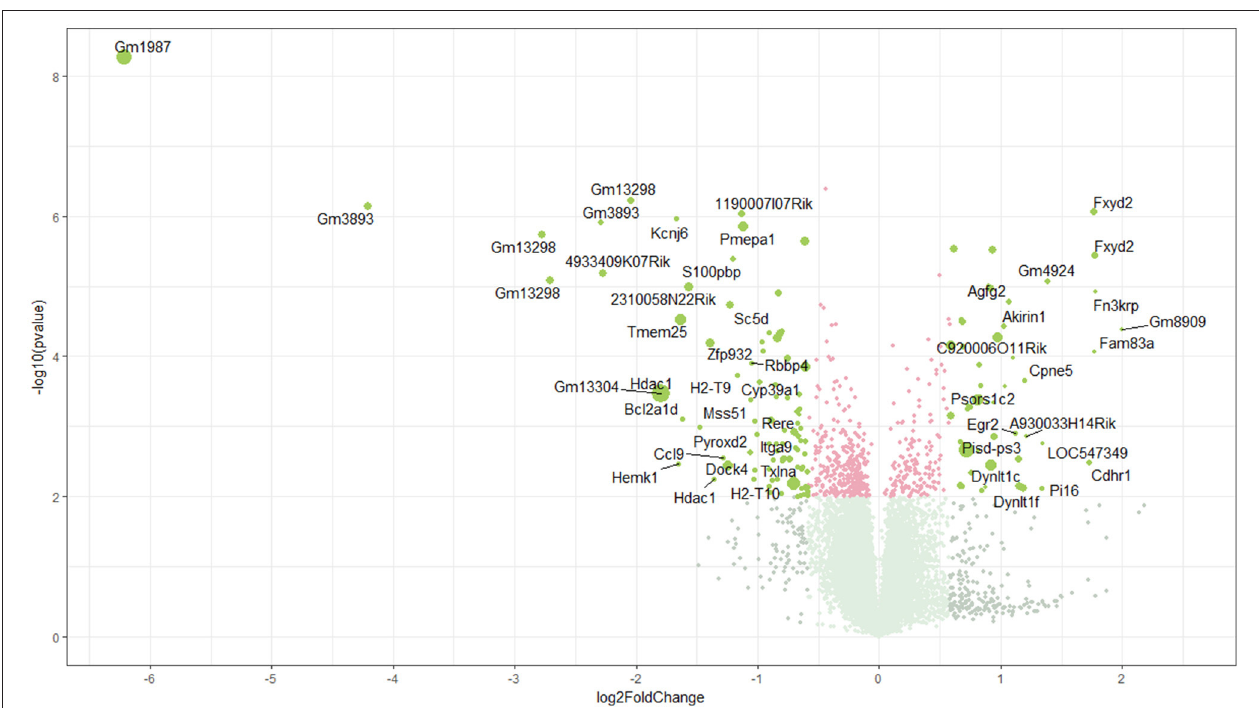
Table 1). Furthermore, 5/7 of the downregulated genes